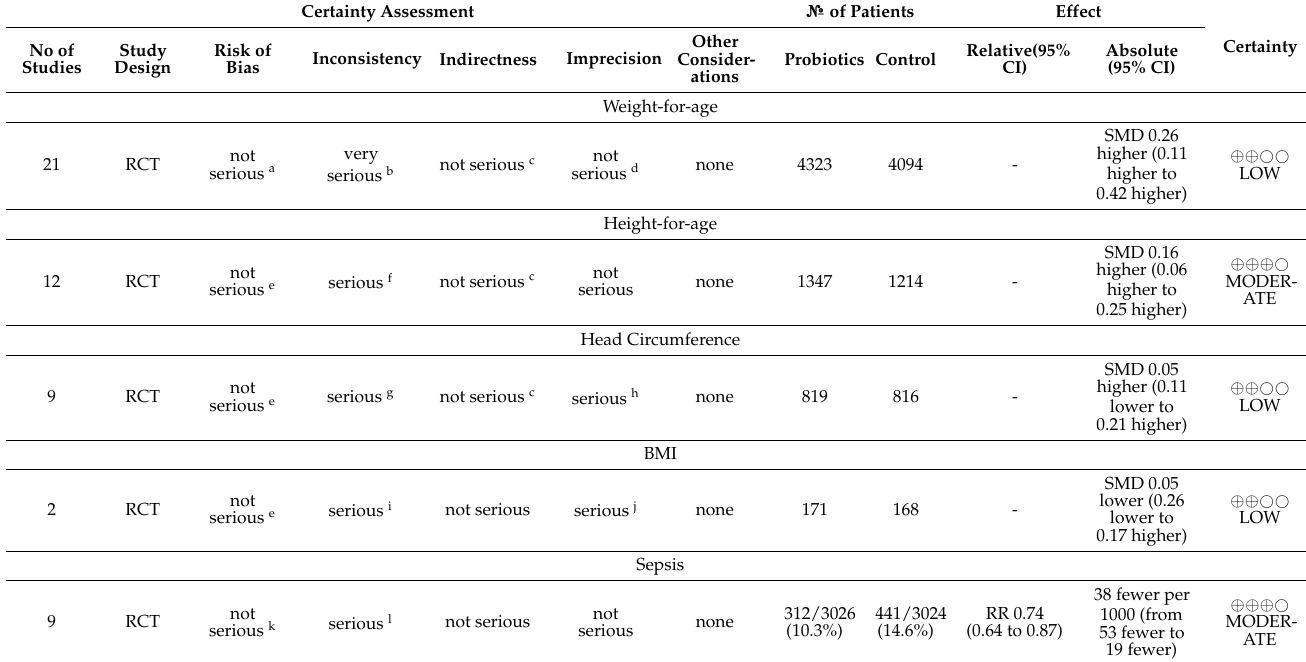
Table 1. GRADE evidence profile showing results of GRADE analysis of overall certainty of evidence for effect of probiotics in children 0–59 months of age in low- and middle-income